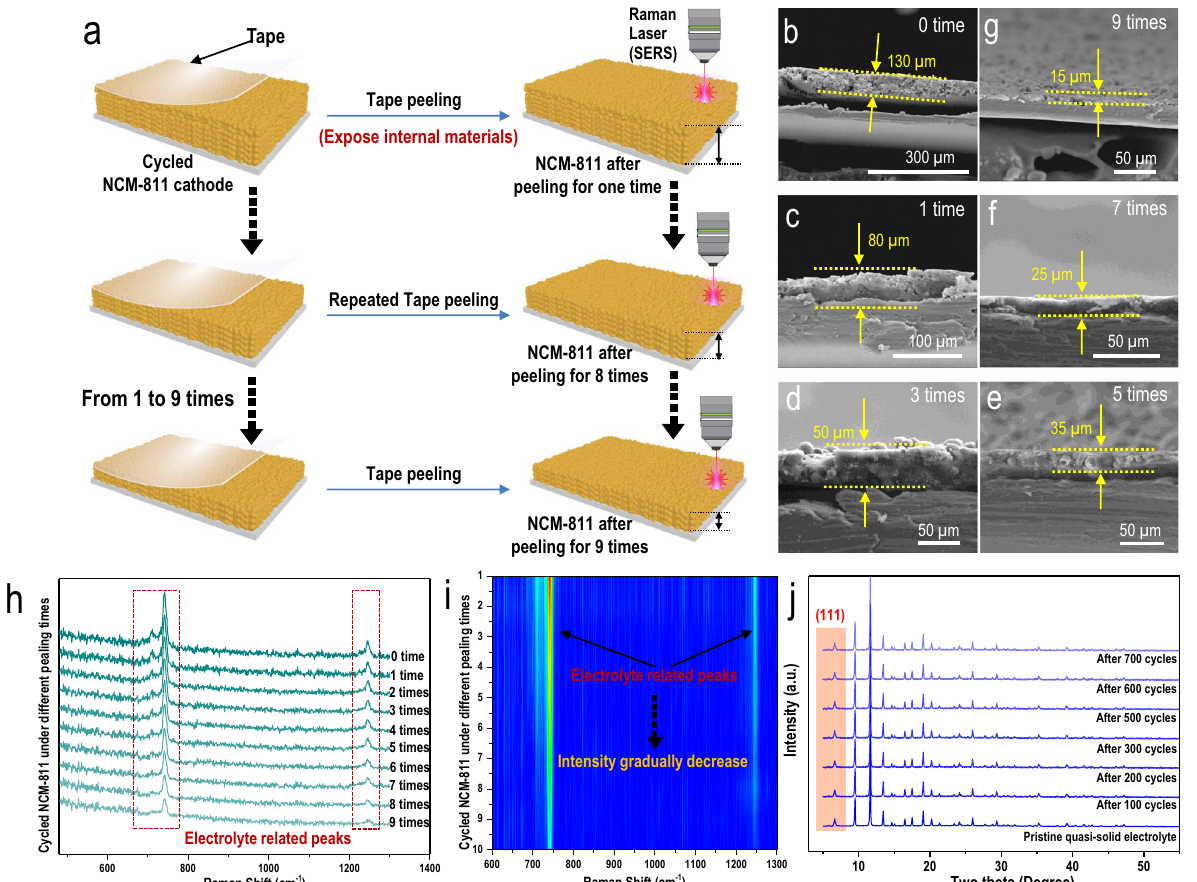
Fig. 5 Characterizations of the cycled quasi-solid electrolyte and cycled NCM-811 cathode at different depths. a Schematic illustration of the tape peeling method employed to peel off certain amounts of NCM-811 materials and expose the internal area of the cycled NCM-811 cathode for the following Raman experiment (after 700 cycles). SEM images of the cycled NCM-811 cathode under tape peeling tests for b 0 times, c 1 time, d 3 times, e 5 times, f 7 times and g 9 times. h Raman spectra detected from the cycled NCM-811 cathode under different times of tape peeling test (from 0 to 9 times) and the corresponding i color mapping. j XRD patterns of pristine and cycled quasi-solid